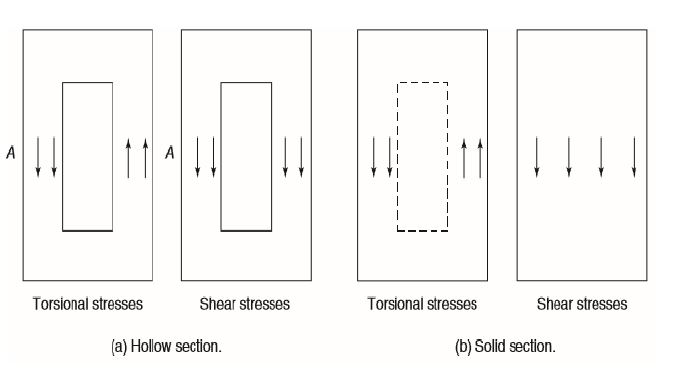
Figure 10: Shear and torsion stresses on a hollow and solid section